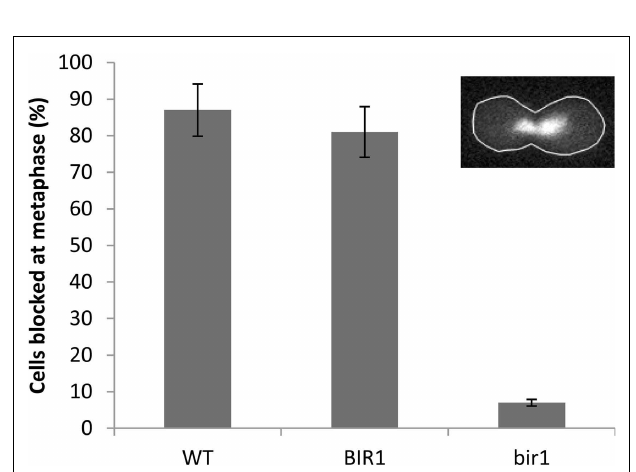
FIGURE 1 | BIR1-degron causes degradation of both BIR1 mRNA (A) and protein (B). BIR1-degron strain was grown in the non-inducing condition (YPDCu, 24˚C) to early log phase. Cells were then transferred to inducing condition (YPG, 37˚C) for 1˚h. PT-PCR (A) orWestern blot (B) was used to examine the mRNA or protein level.